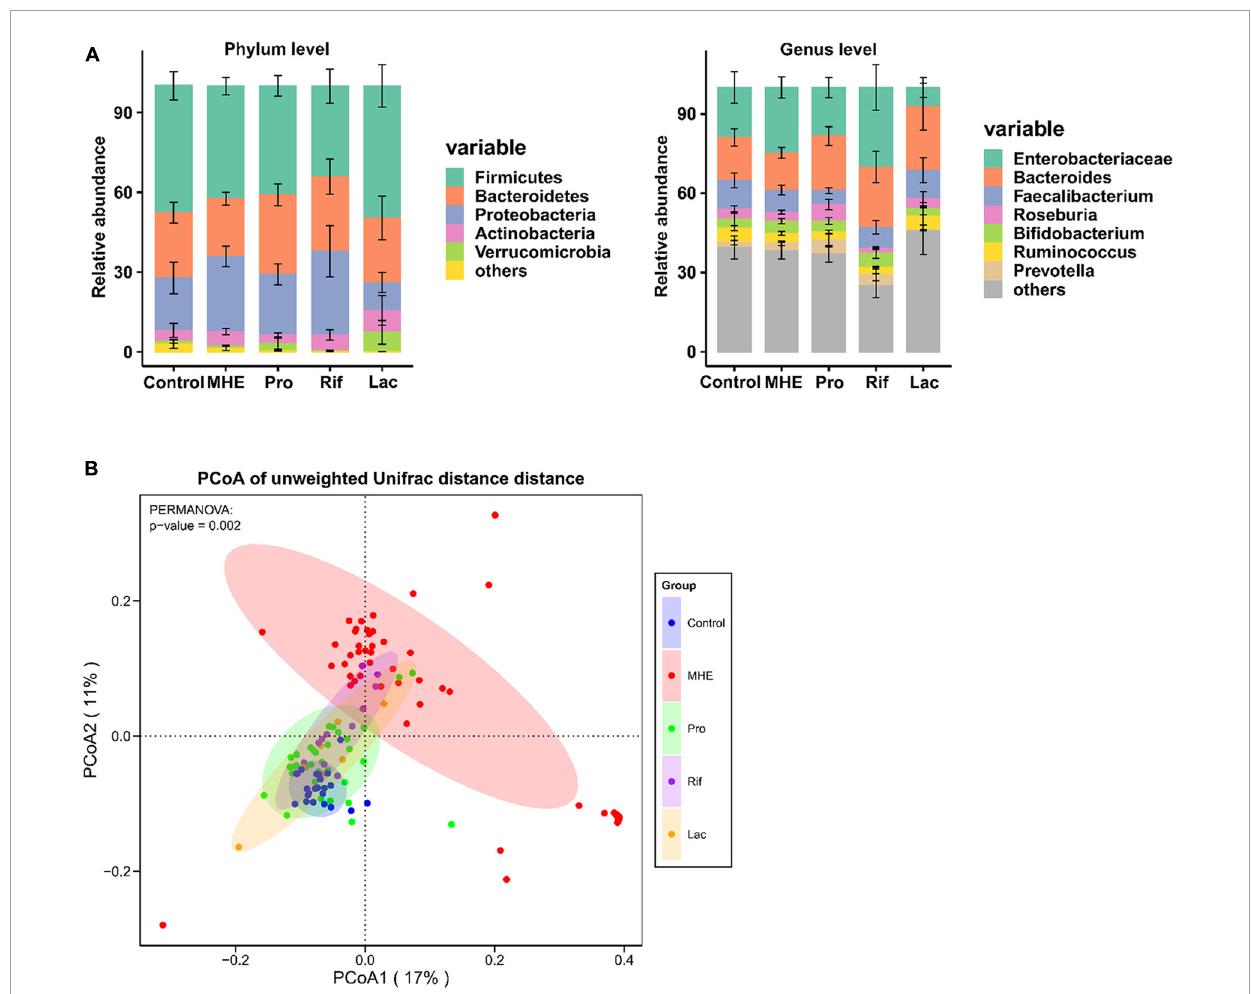
FIGURE3 The gut microbiota in MHE patients and controls. (A) Compositions of intestinal microbiota in different groups. (B) PCoA based on unweighted UniFrac matrix of bacterial taxonomy in all patients and control individuals.